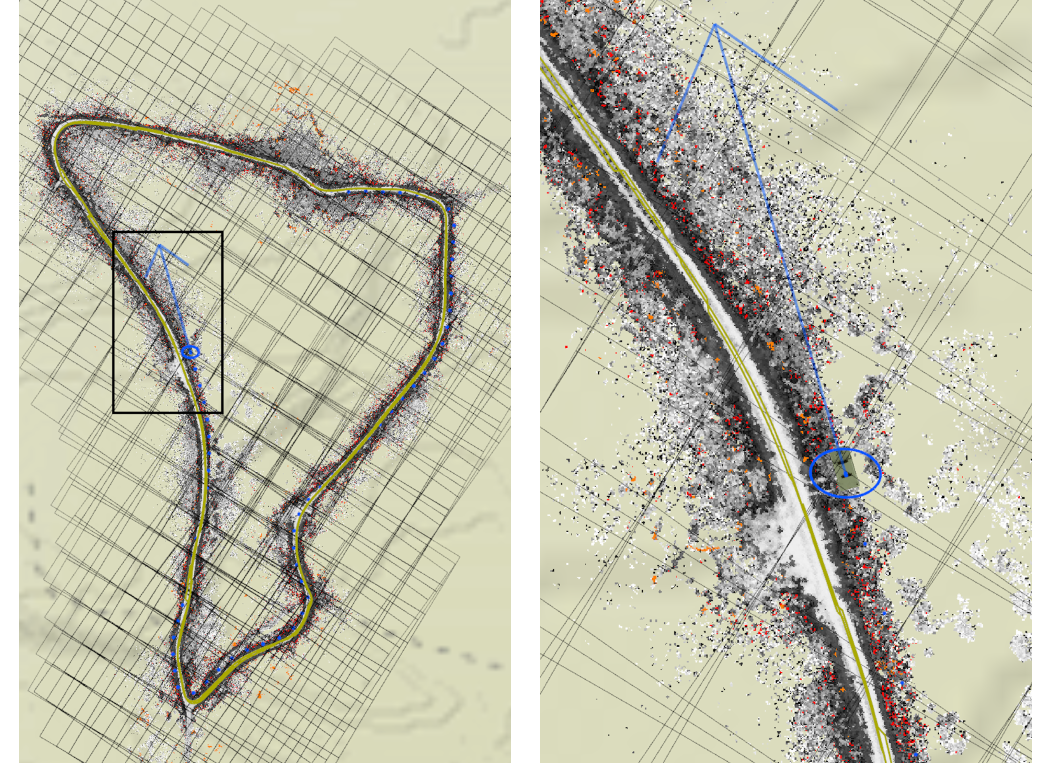
Figure 7. Localizing to an evolving map in off-road conditions. Here, the map from Figure 5 (on the left) is used to localize the vehicle even as it is evolves. The blue dots around the trail indicate the derived localization of the vehicle, with the blue ellipse showing the covariance of the estimate. The blue arrow indicates direction. The scattered dots off-trail are costmap data, including black- and-white for valid data, red for lethal obstacles, and orange for missing data. The map on the right, comprising the boxed area around the vehicle, show a zoomed-in view of the vehicle and its immediate